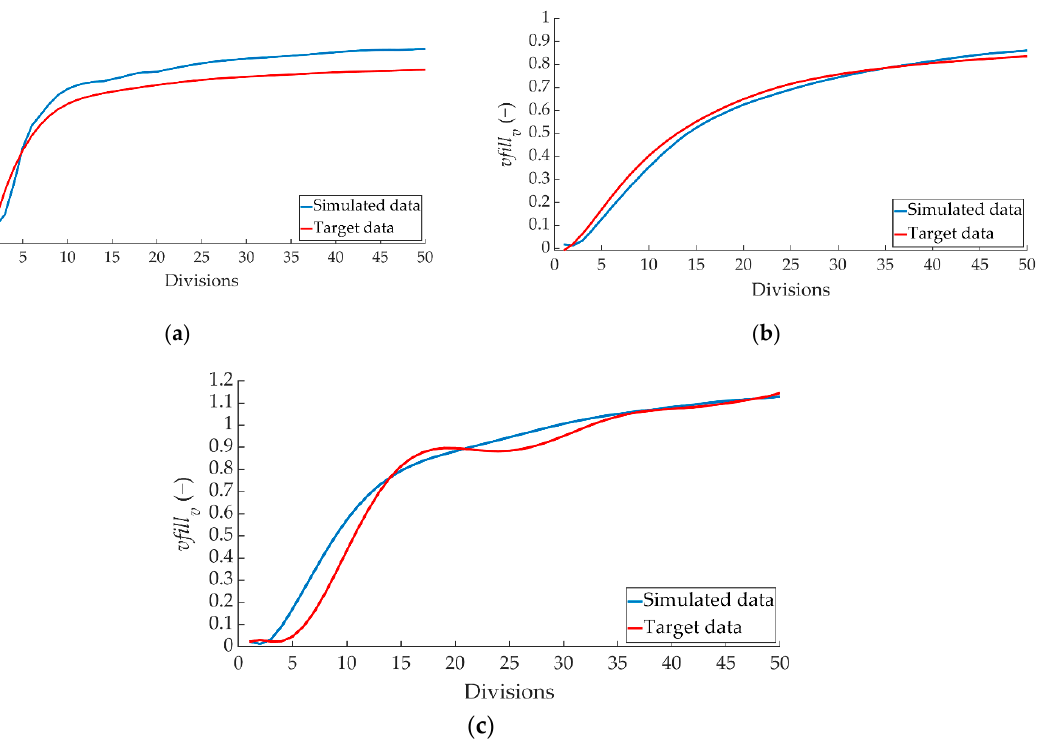
Figure 22. Comparison between ANN simulated data and vfill v target data for the left pressure sensor for braking at a speed of 70 km/h for the type: ( a ) maintained, ( b ) progressive and ( c ) emergency. Another of the simulated data refers to the type of braking performed. The compari- son between the simulated values and the target data of the braking type parameter for the three types of braking is shown in Figure 23.